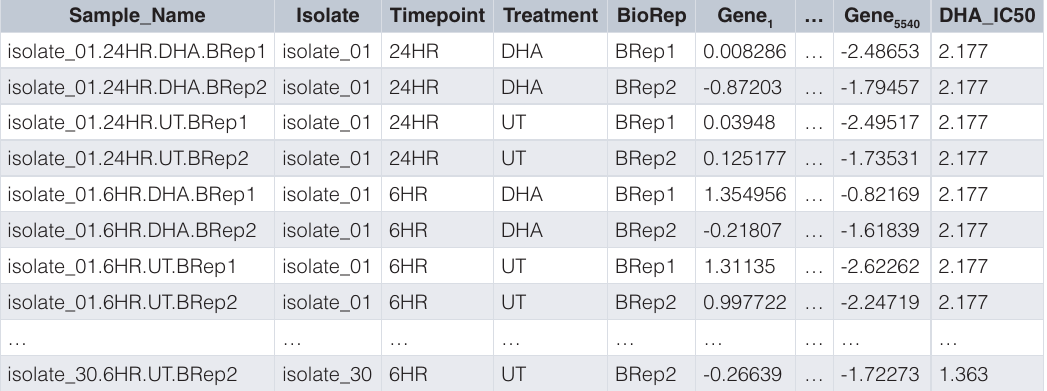
Table 1. Initial IC model training data format. Note that for Treatment, UT represents untreated samples and DHA 50 represents samples treated with